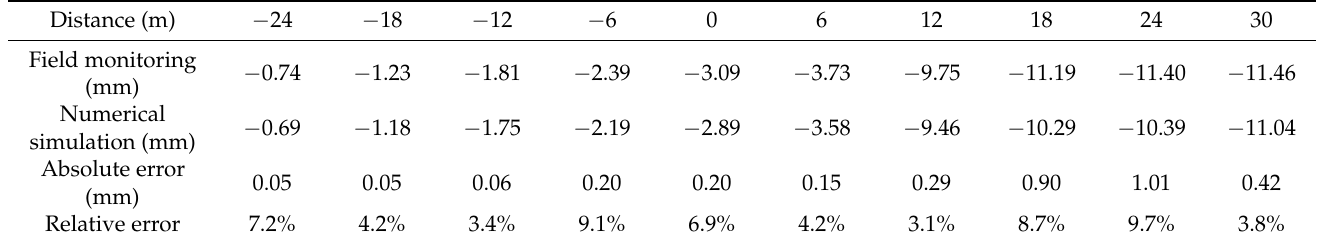
Table 4. Longitudinal surface displacements of A 12 and hole 3